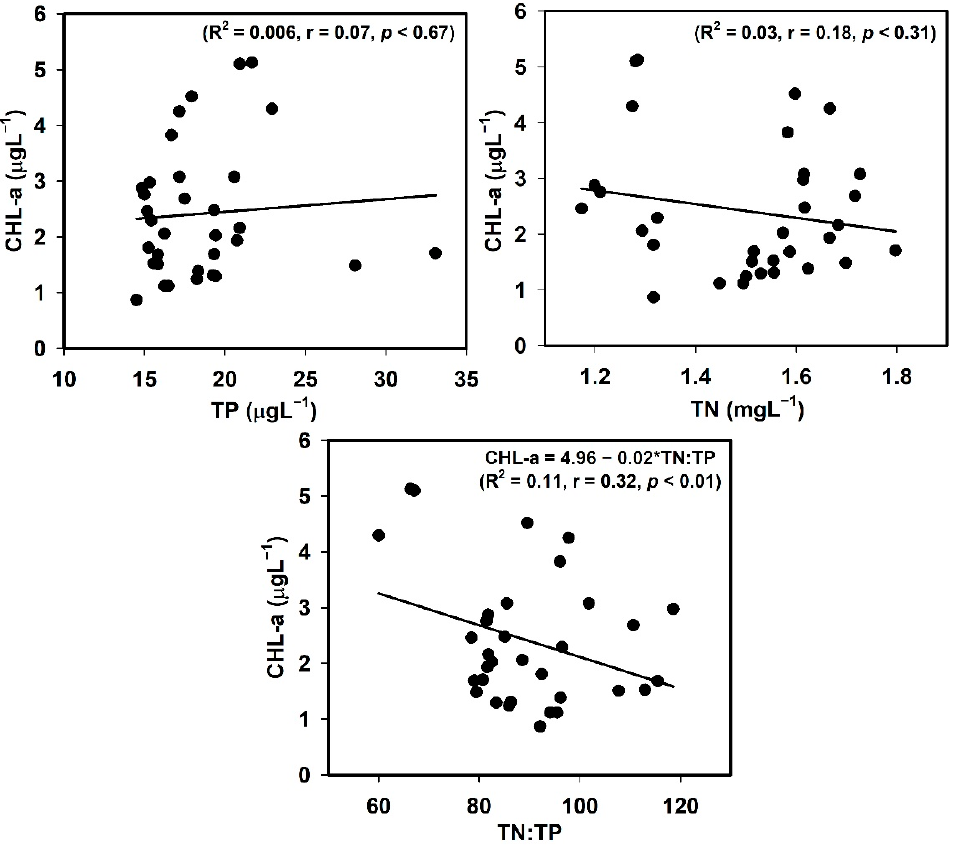
Figure 5. Empirical relationships between total phosphorus (TP), total nitrogen (TN), TN:TP ratio, and chlorophyll-a (Chl-a).